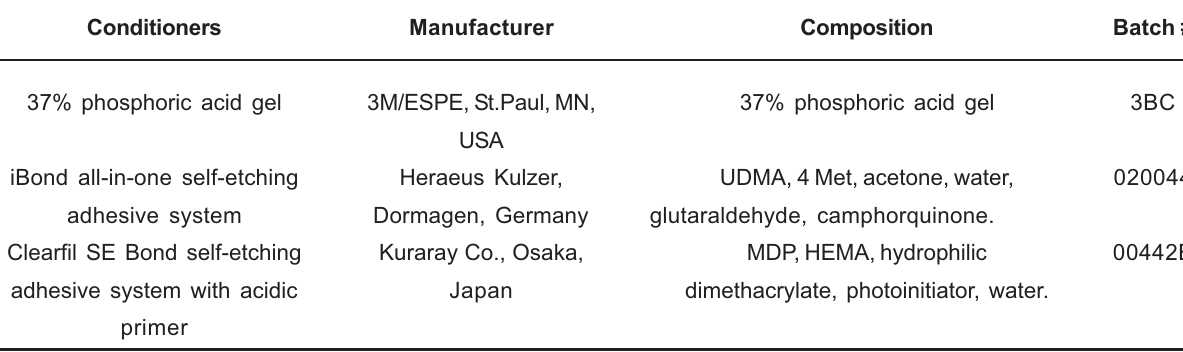
TABLE 1- Groups, conditioners and respective treatment protocols